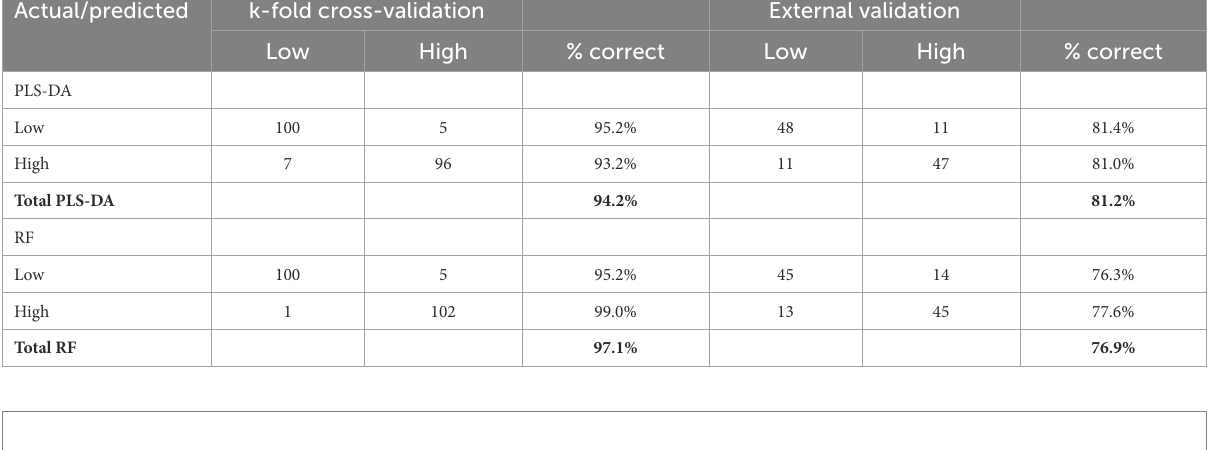
TABLE 1 Identification of Staphylococcus aureus strains: k-fold cross-validation and external validation. Actual/predicted